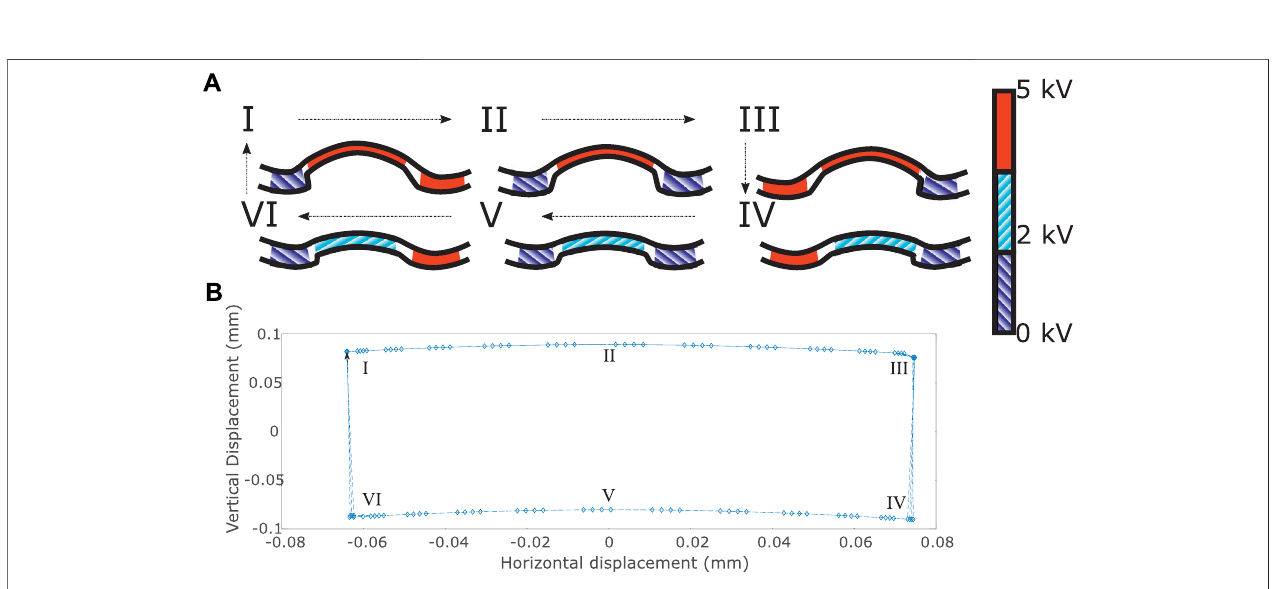
FIGURE 14 | Path taken by the end point of each foot. (A I – VI) shows the actuation of the DEAs in a “ foot ” during the cycle. Red segments are actuated, blue segmentsarerelaxed. (B) — FEMdataoftheexpectedtipdisplacementduringfourcyclesusinga3 kVsquarewavewithanoffsetof2 kVappliedtothe “ feet ” anda5 kV peak-to-peak sinusoidal wave with a 2.5 kV DC offset applied to the smaller electrodes. I-VI show the progression of the cycle on each diagram.